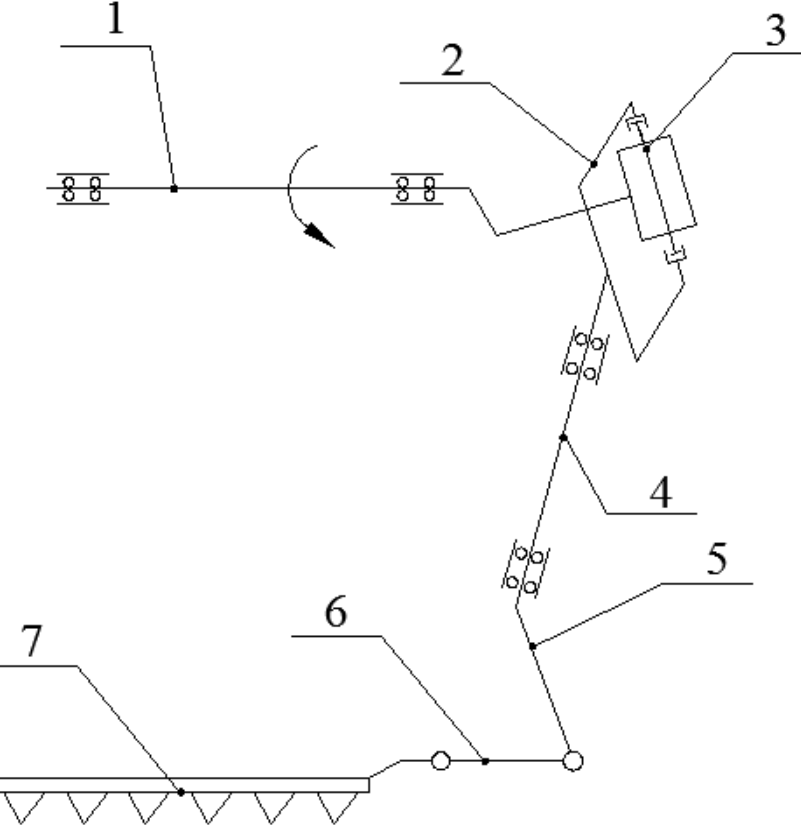
Figure 5. Principle diagram of reciprocating cutter. Note: 1. spindle; 2. swing fork; 3. swing ring; 4. swing fork shaft; 5. swing arm; 6. guide rod; 7. cutter.